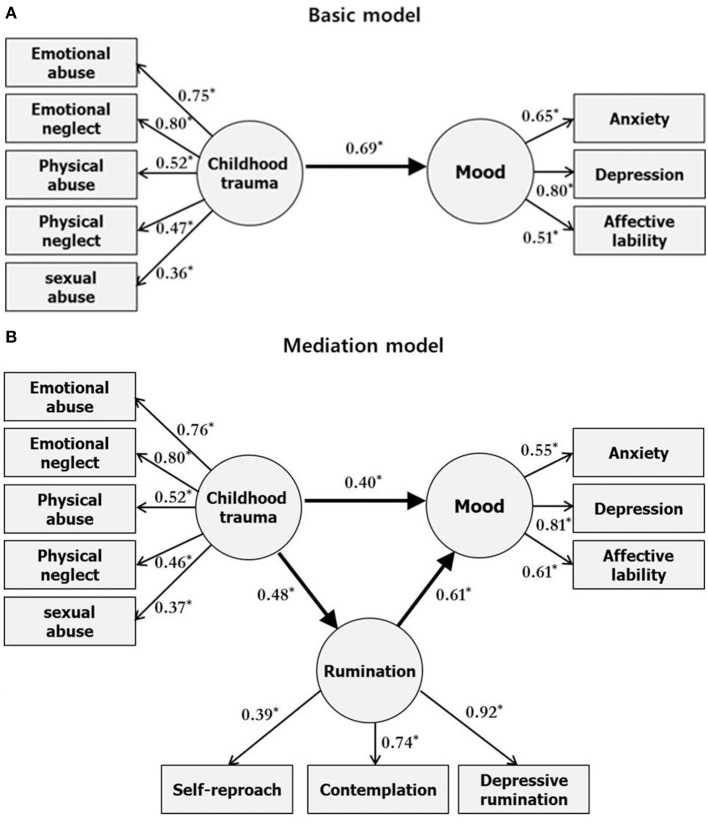
Basic model of the relationship between childhood trauma and mood (A), and mediation model showing rumination as a mediator of the relationship (B) in male participants. Rectangles represent observed variables. Circles represent latent variables. Numbers on single-headed arrows indicate standardized regression weights. *p < 0.05, multiple regression analysis.